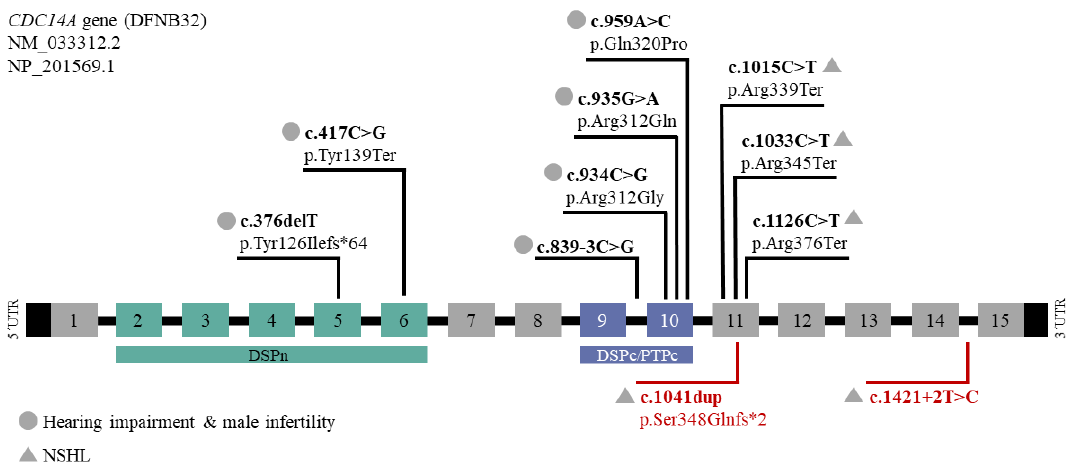
Figure 4. Summary of all variants in the gene CDC14A (NM_033312.2, NP_201569.1) that is composed of 15 exons. The dual-specificity phosphatase domain (DSPn) and the core dual-specificity phosphatase domain (DSPc/PTPc) are represented in green and blue bars, respectively. Indicated are the nine previously described mutations (above) and the two newly identified variants in the a ff ected individuals from family 1 and 2 (red, below). The two di ff erent phenotypes are indicated with a circle (hearing impairment and male infertility) or triangle